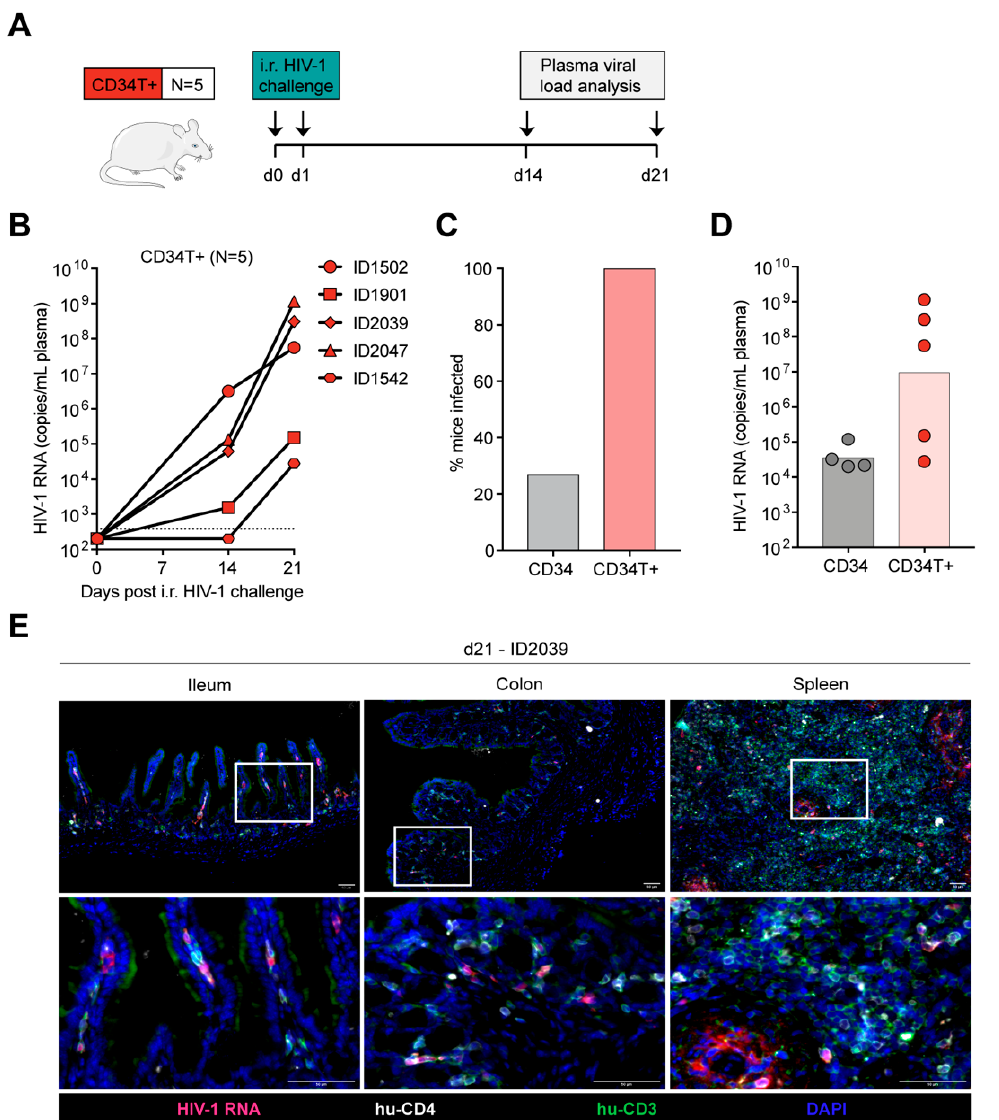
Figure 2. Efficient mucosal transmission of HIV-1 in CD34T+ mice. ( A ) Schematic representation of the experiment design. CD34T+ control mice were given i.r. challenges with NL4-3 YU2 HIV-1 on consecutive days and bled at the indicated time points for viral load measurements. ( B ) Plasma HIV-1 RNA levels in the blood of CD34T+ mice after intra-rectal challenge with NL4-3 YU2 HIV-1. The dotted line represents the quantification limit of 384 HIV-1 RNA copies/mL of the assay. ( C ) Comparison of infectivity rates (in %) of CD34 and CD34T+ mice post i.r. HIV-1 challenge. ( D ) Plasma HIV-1 RNA levels at week 3 after i.r. challenge with HIV-1 of CD34 and CD34T+ mice. ( E ) RNA-scope-based detection of HIV-1 infected cells in the ileum, colon and spleen of CD34T+ mice harvested at day 21 post i.r. HIV-1 challenge. HIV-1 RNA (pink), CD4+ cells (white), CD3+ cells (green) were labeled by in-situ hybridization and IF and nuclei were stained with DAPI. Scale bar is 50 µ m. 3 mice per group and 3 tissue sections per mouse were analyzed. Representative images were selected for display. i.r. intra-rectal.